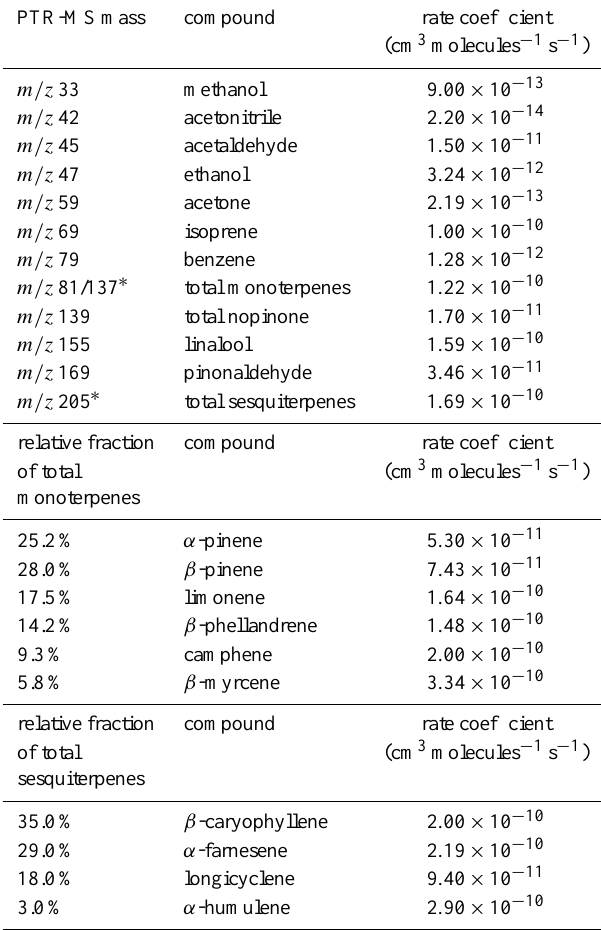
Table 1. PTR-MS measured and calibrated VOCs, and the applied rate coefficients used for OH reactivity calculations. The reaction rate coefficients were taken from the IUPAC preferred values except for nopinone, which was measured by Calogirou et al. (1999) and pinonaldehyde (Davis et al., 2007). The second part of this table in- cludes the compounds identified by the speciation of monoterpenes and sesquiterpenes using GC-MS. All presented reaction rate coef- ficients are IUPAC preferred values except β -myrcene, which was taken from Hites and Turner (2009) and α -farnesene from Kim et al.